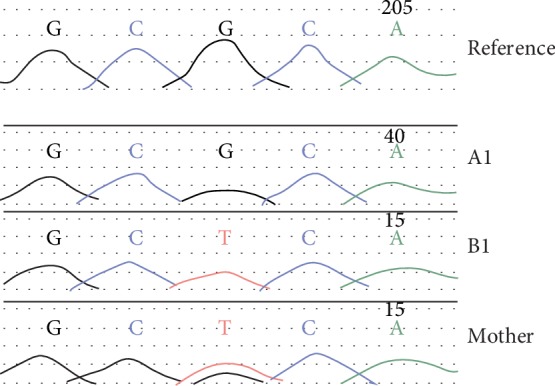
Sanger sequence analysis for A1, B1, and their mother showing nucleotide change C>A, heterozygous.